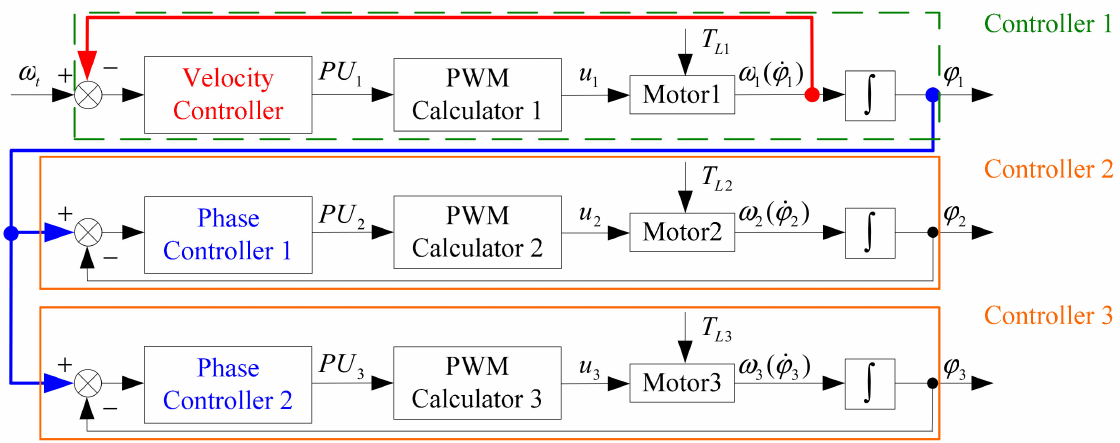
Figure 3. Control synchronization scheme of three